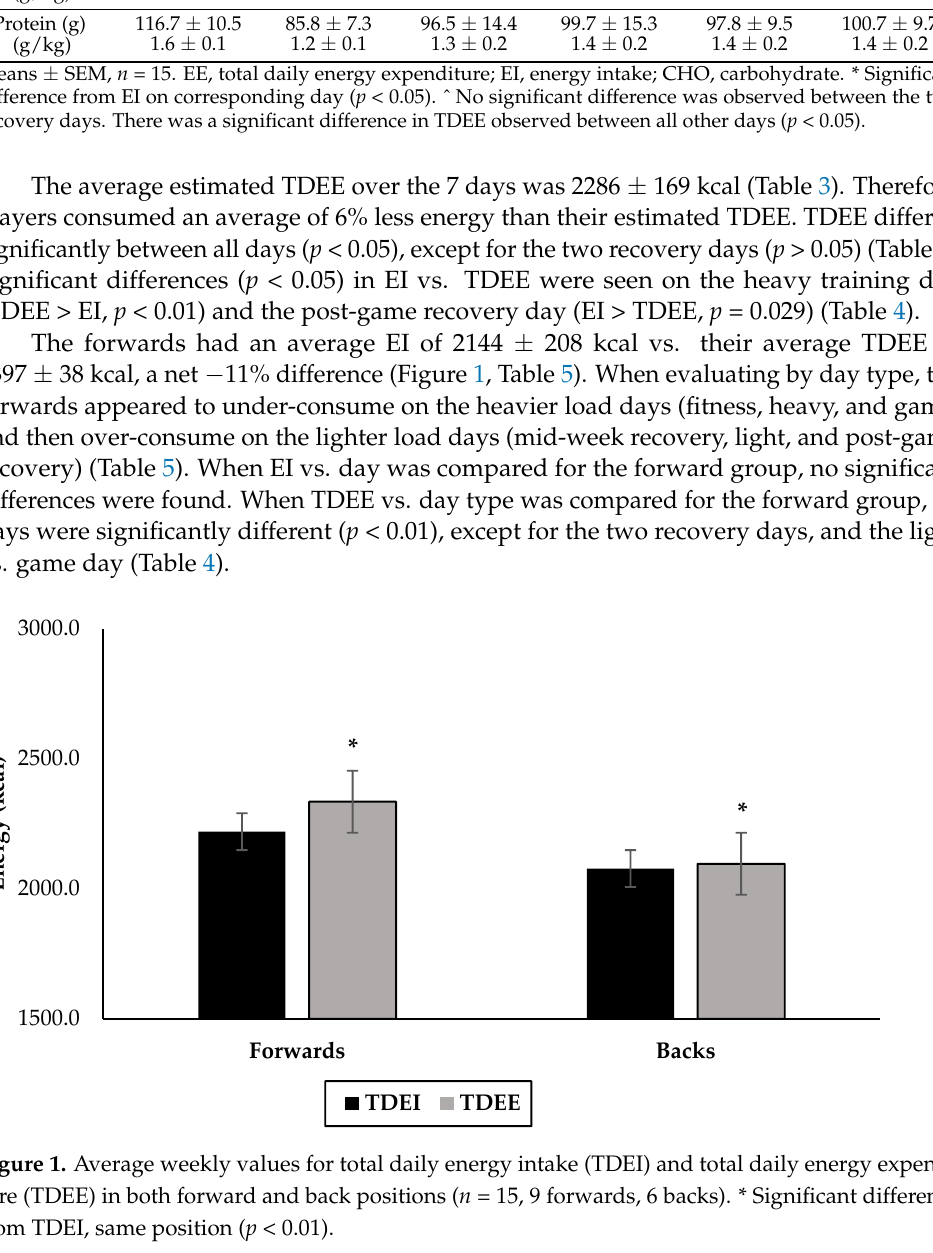
272 Figure 2. Average daily EA values for 6 different day loads for forward and back positions ( n = 15, 273 9 forwards, 6 backs). * Significantly different from heavy day ( p < 0.05). ^ Significantly different from 274 post-game recovery day ( p < 0.05). 275